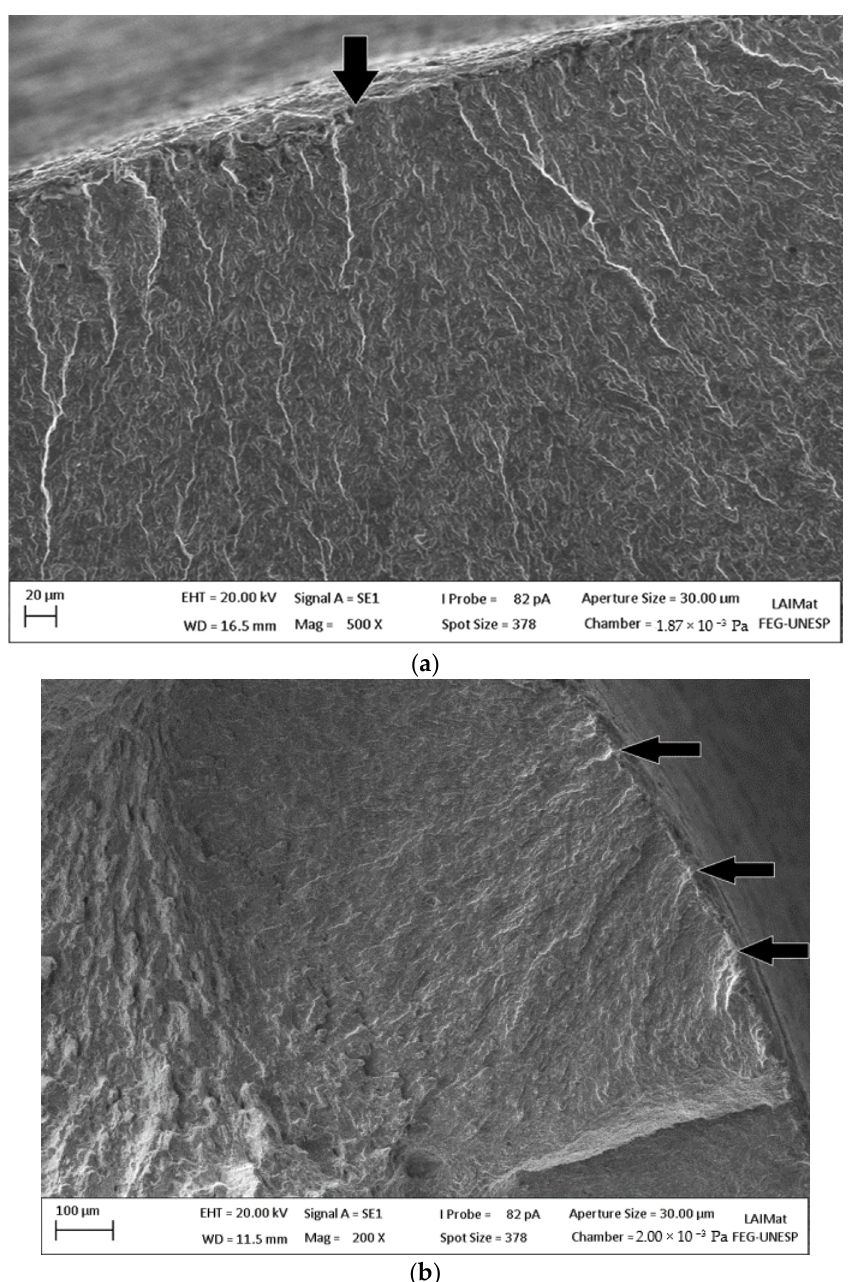
Figure 21. Fractography of a Zn-Ni coated standard specimen tested at a maximum stress of ( a ) 837 MPa (2.98 × 10 4 cycles) and ( b ) 916 MPa (2.08 × 10 4 cycles).